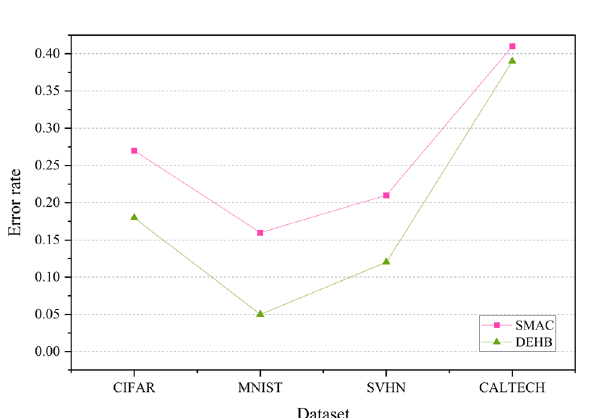
Figure 4. Test set classification error plot of an AlexNet model that uses the HPO packages—SMAC and DEHB. The figure represents the average test error rate across the datasets—CIFAR, MNIST, SVHN and CALTECH (based on 20 iterations). SMAC is a BO package and DEHB combines DE and Hyperband. The results are obtained using the Wilcoxon Rank-Sum test on samples from 20 iterations with a statistical significance of p < 0.05